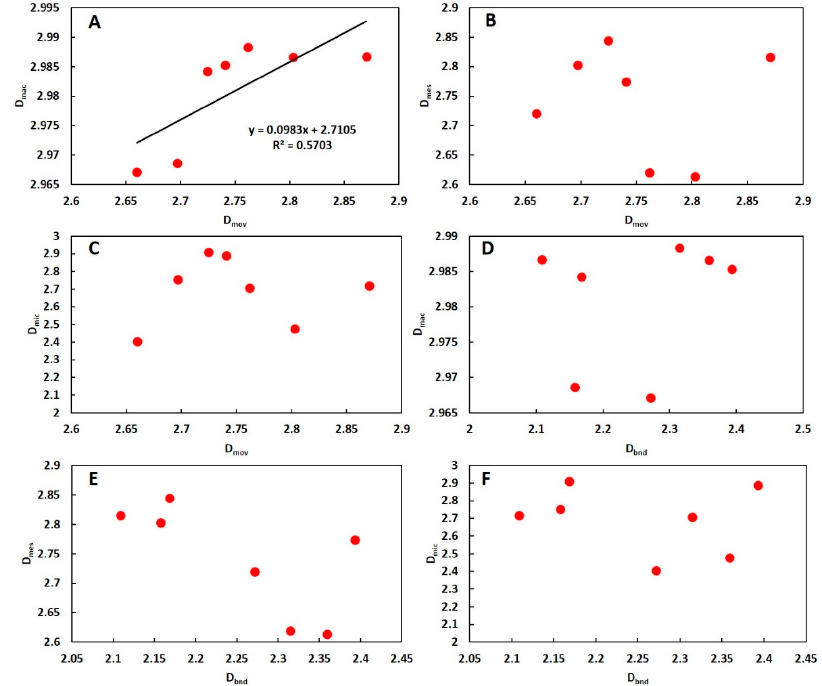
Figure 18. Trends of fractal dimensions from NMR and HPMI.